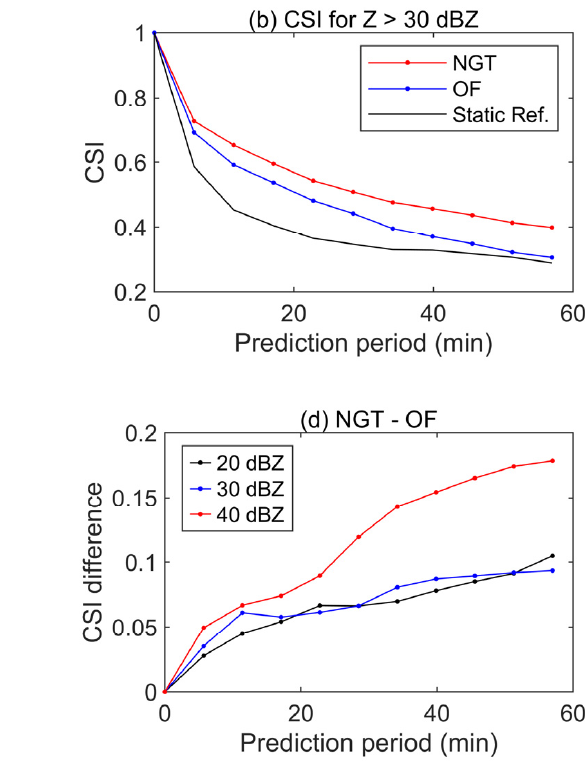
Figure 11. CSI of the prediction by NGT and OF for ( a ) Z > 20 dBZ, ( b ) Z > 30 dBZ, ( c ) Z > 40 dBZ, and ( d ) NGT—OF. The prediction starts at 14:25 UTC on 17 May 2020. Table 2. Skill scores of the two methods for 60 min prediction. The target time is 15:22 UTC on 17